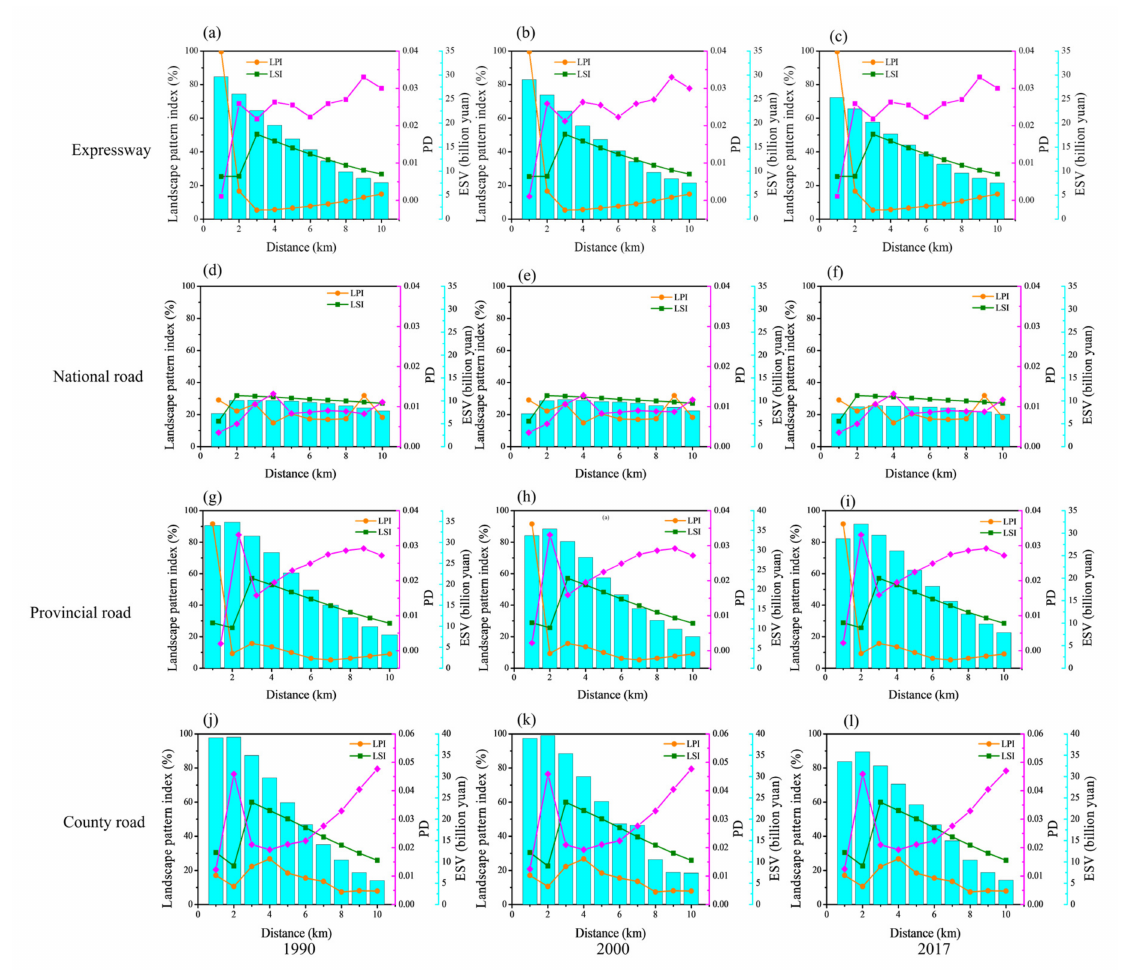
Figure 5. Landscape index and ESVs anges in ( a – c ) expresschway buffer zone, ( d – f ) national road buffer zone, ( g – i ) provincial road buffer zone, ( j – l ) county road buffer